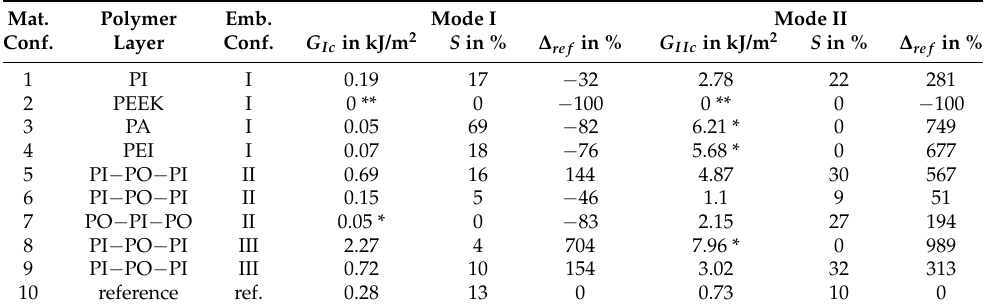
Table 3. Determined Mode I and II energy release rates with the respective deviation from the reference configuration ∆ ref